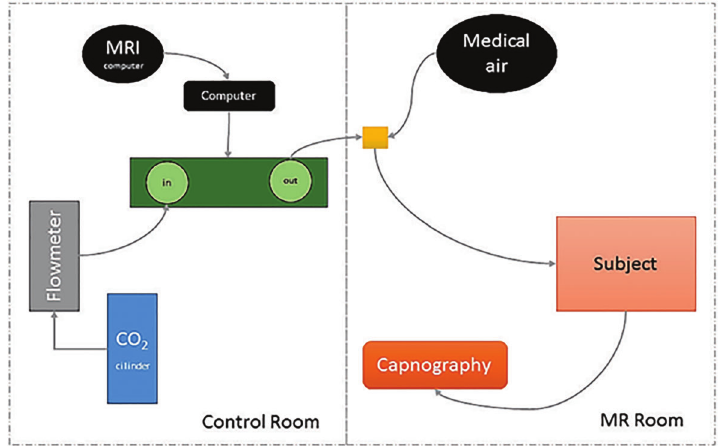
Figure 1. Schematic experimental setup. CO 2 goes through the fl owmeter into a device consisting of micro-valves controlled by a software and synchronized with image acquisition. When the valves open, CO 2 goes through a rubber tube into the magnetic resonance (MR) room, where it mixes with medical air. This gas mixture is delivered to the participant through a nasal cannula, which also has a connection with an MR-compatible vital sign monitor (capnography) to continuously check and record the physiological parameters (end-tidal CO 2 , SpO 2 , heart rate and respiration rate) during the